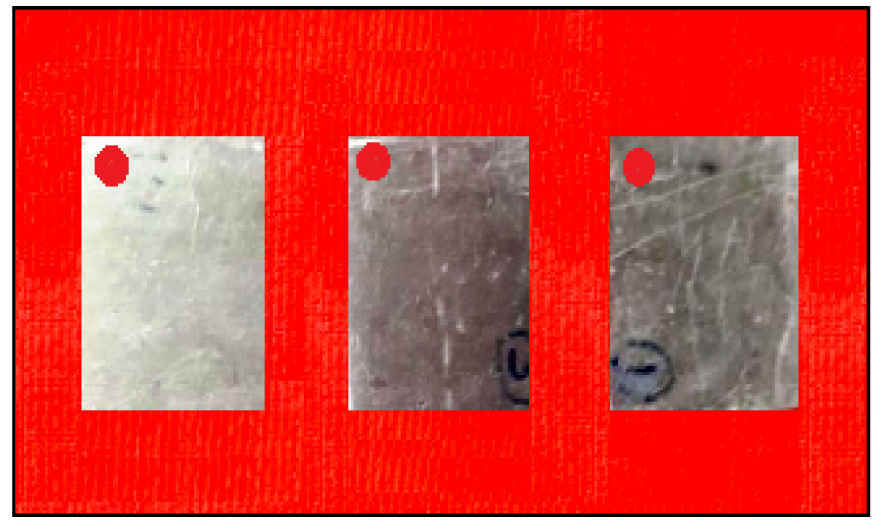
Figure 5. Photographic view of corrosion